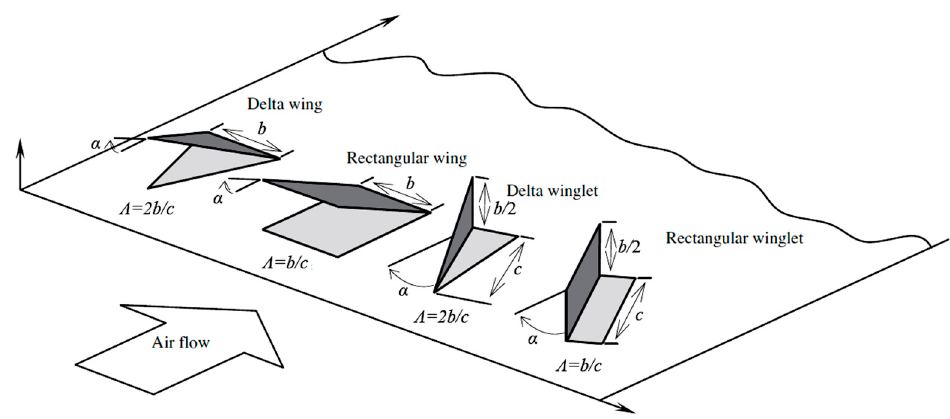
Figure 1. Common vortex generators and the associated geometrical definitions [8,12,14].